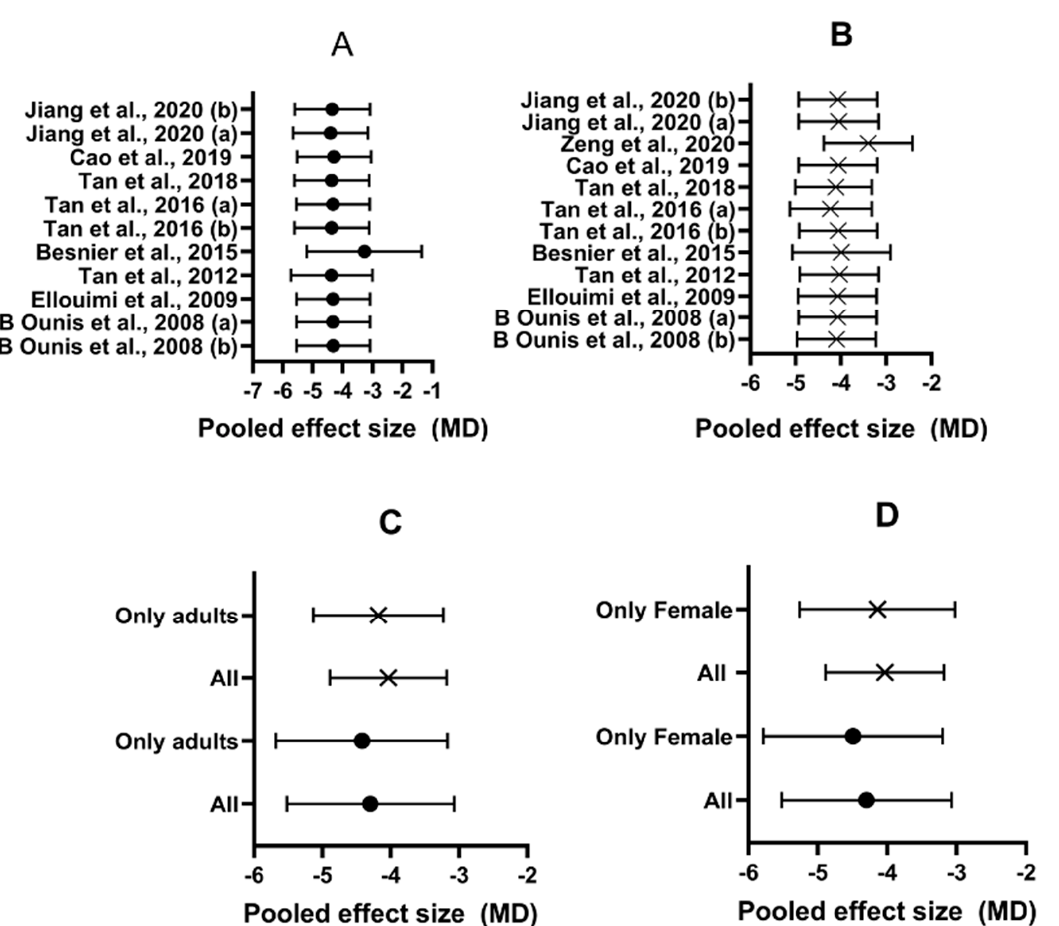
Figure A1. Sensitivity analysis for body weight (circles) and fat mass (x) outcomes. Each horizontal plot represents pooled effect size (mean difference) and 95% confidence interval. Exclusion of each study data ( A , B ), studies in adults vs. overall effect ( C ), studies in female participants vs. overall effect ( D ).